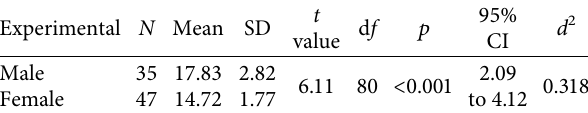
Table 3: Independent sample t -test statistics for testing the mean difference in the performance scores of male and female students in the experimental